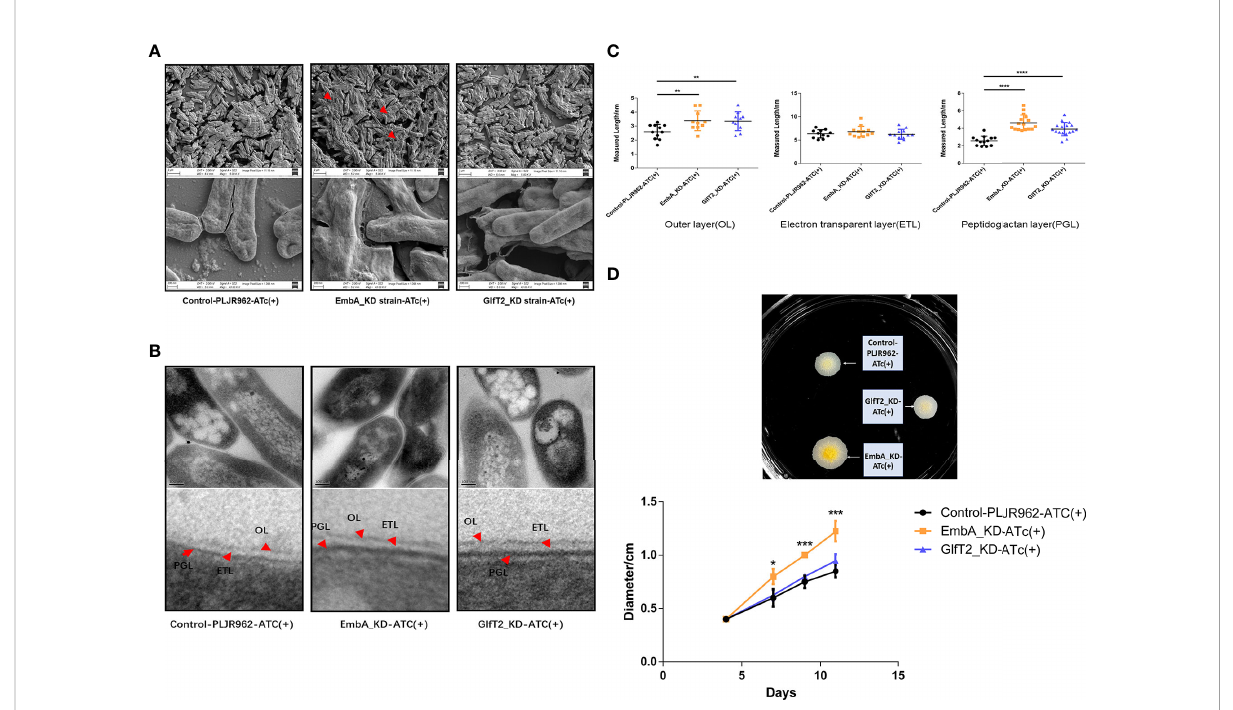
FIGURE 2 Cell wall structure of knock-down strains in the scanning electron microscopy (SEM) and transmission electron microscopy (TEM) fi elds. (A) The control PLJR962 strain and EmbA/GlfT2_KD strains were observed by SEM at ×10,000 and ×100,000 magni fi cation. The red arrow indicates the extracellular material around the bacteria. (B) TEM observation of the control PLJR962 strain and EmbA/GlfT2_KD strains at ×100,000 magni fi cation and partial enlargement of the cell wall. The red arrows indicate the outer layer (OL), electron transparent layer (ETL), and peptidoglycan layer (PGL). (C) A uni fi ed scale is used to measure the thickness of OL, ETL, and PGL layers of each strain from (B) in all visual fi elds by Image J software. The cell walls of three bacteria in each visual fi eld were taken for measurement. Data are plotted as mean ±